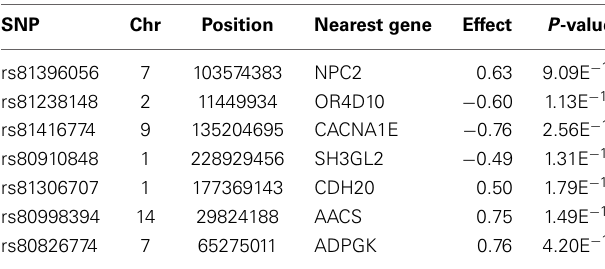
Table 1 | Description of a selection of highly significant SNPs associated with the Obesity